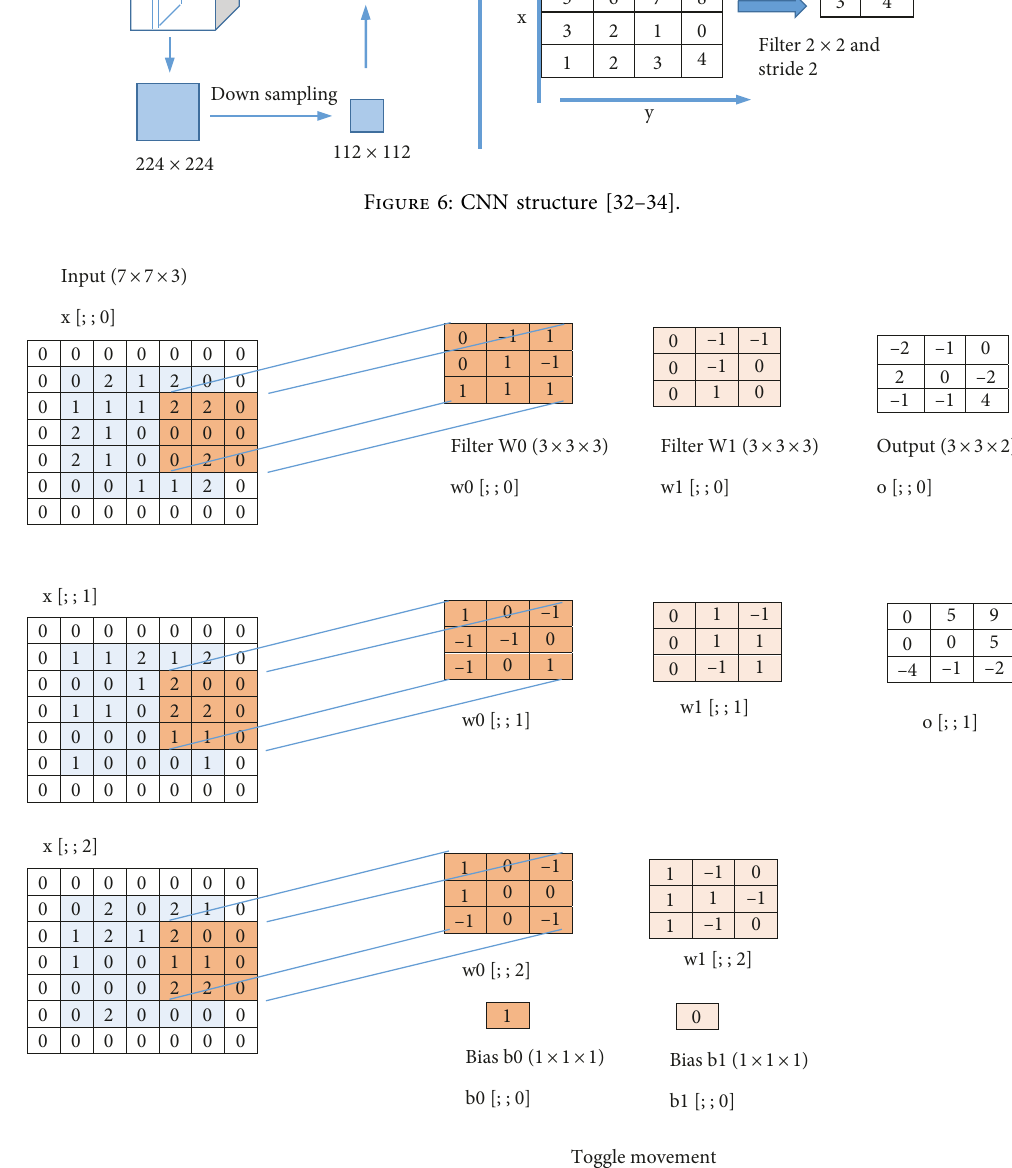
Figure 7: Performing convolution on color images [29, 30].